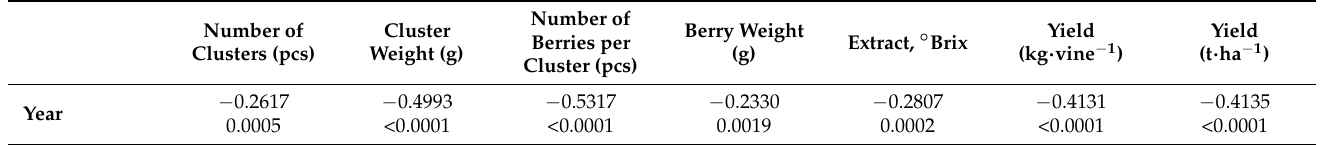
Table 4. Multivariate Pearson correlation analysis for time and weather conditions regardless of rootstock type against yield size and quality